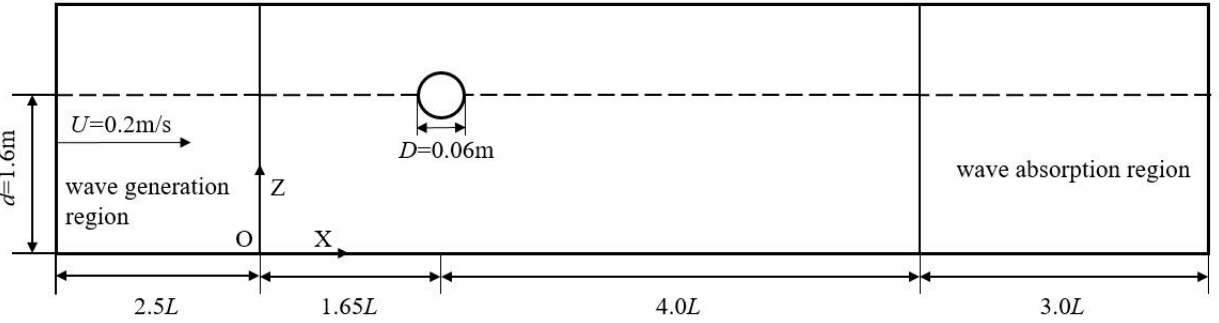
Figure 6. Computational domain of water channel.